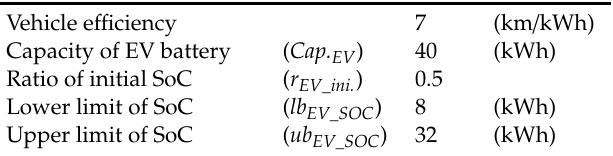
Table 2. Characteristics of EV.